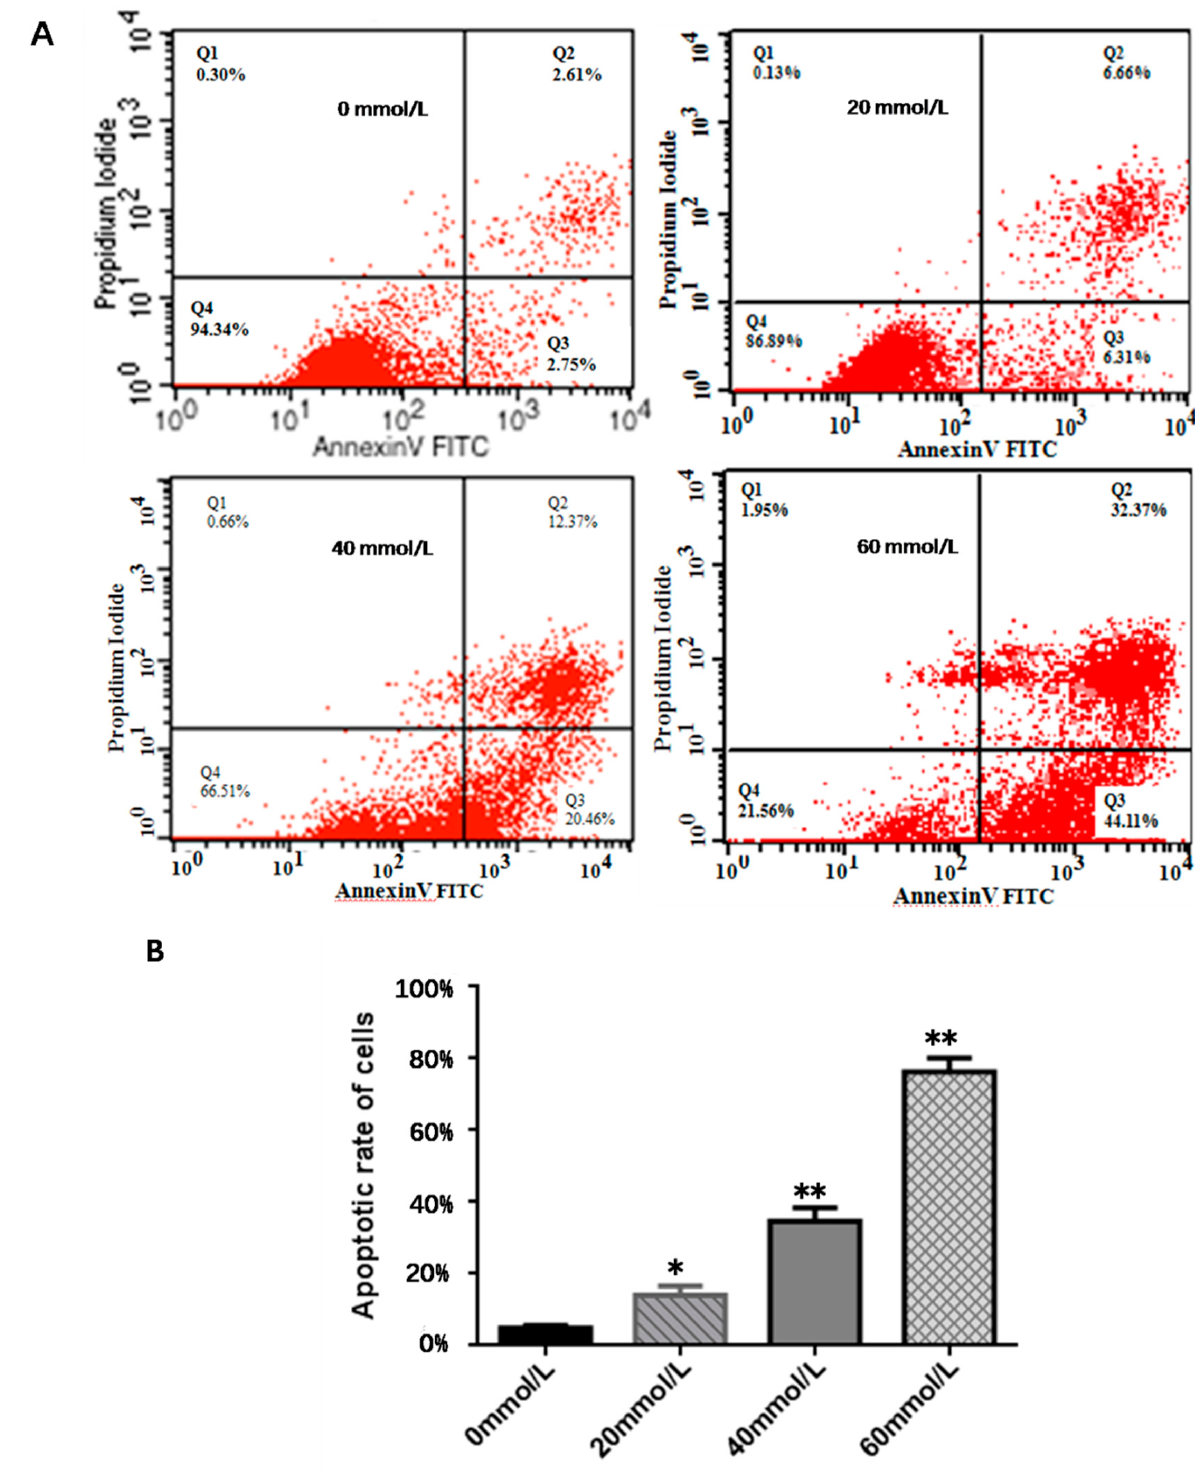
Figure 3. pGC apoptosis detection. ( A ) Effects of different concentrations of 2,5-HD (0 mmol/L, 20 mmol/L, 40 mmol/L, and 60 mmol/L) for 24 h on pGC apoptosis by flow cytometry. ( B ) Effects of different concentrations of 2,5-HD (0 mmol/L, 20 mmol/L, 40 mmol/L and 60 mmol/L) for 24 h on pGC apoptosis. Compared to the control group, n = 3, * p < 0.05, ** p < 0.01. All experiments were repeated 3 times.